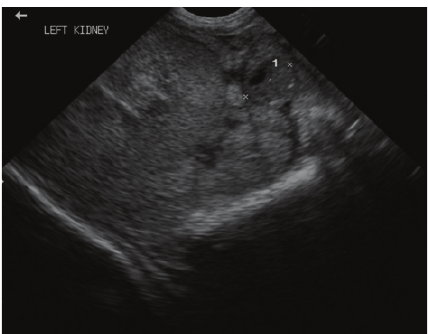
Figure 1: Ultrasonographic image of the left kidney obtained from the right paralumbar fossa. Note the increased thickness of the renal cortex and the multiple masses in the perirenal region. Obtained with a 5MHz microconvex transducer. Left is dorsal; right is